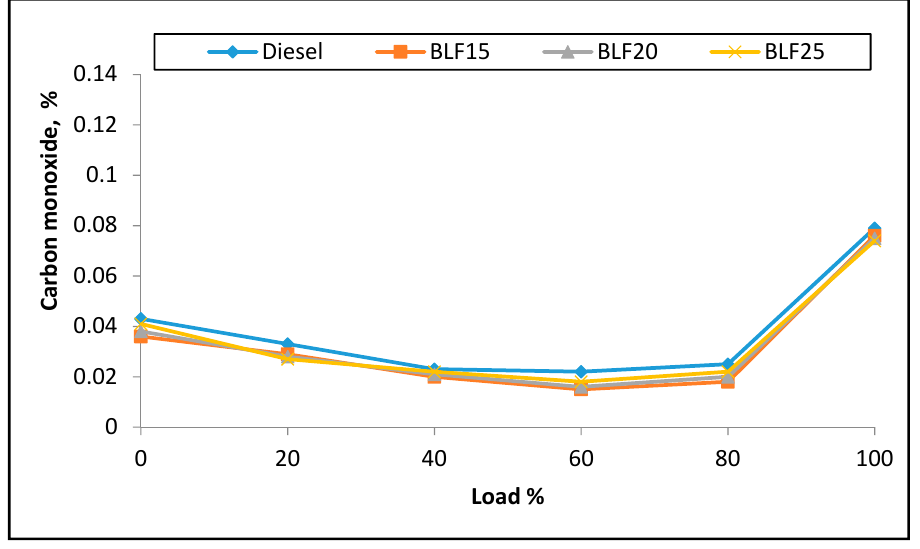
Figure 10. Variations of CO vs. load percent.